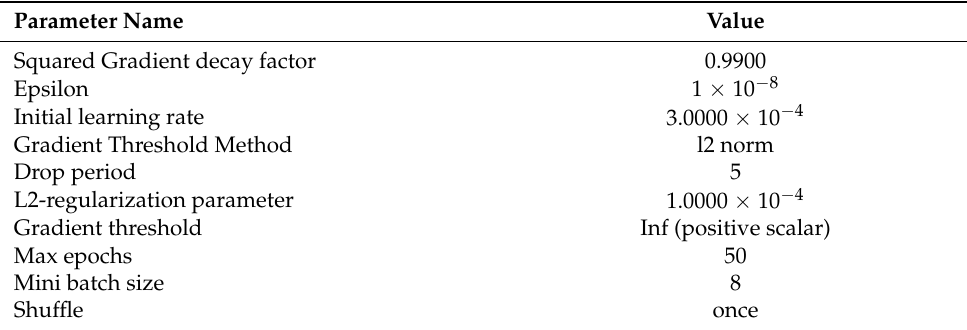
Table 3. Optimal set of parameters for the 8-layer networks.